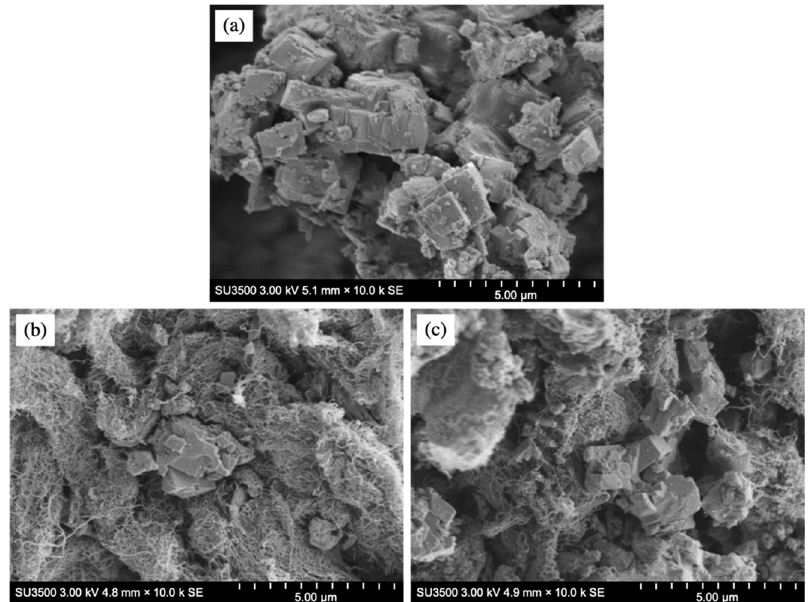
Figure 5. SEM images of ( a ) barium titanate (BaTiO 3 ), ( b ) BaTiO 3 /MWCNT composite (1:1), and ( c ) BaTiO 3 /MWCNT composite (2:1).